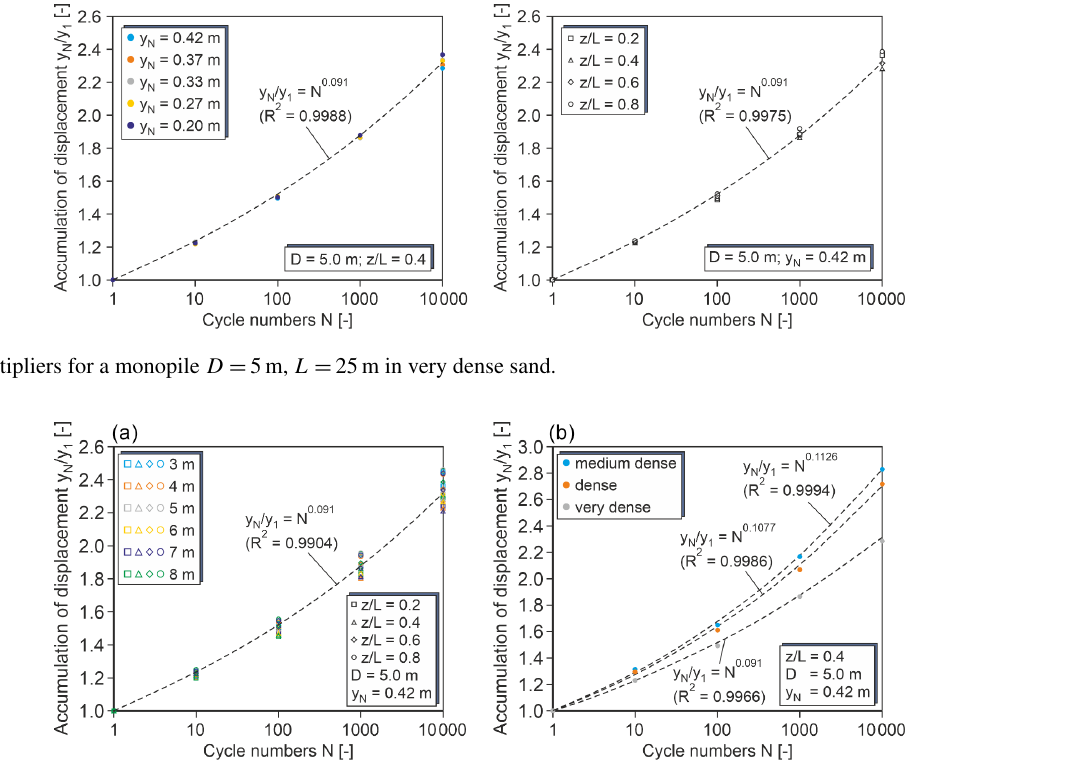
Figure 7. y multipliers for variable pile diameters (a) and for different relative densities of the sand (b) .